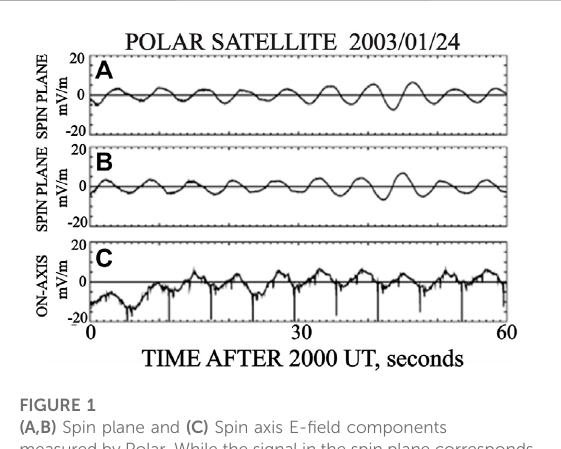
FIGURE 1 (A,B) Spin plane and (C) Spin axis E- fi eld components measured by Polar. While the signal in the spin plane corresponds to a geophysical signal, the signal along the spin axis presents a large error, leading to a large uncertainty in the 3D E- fi eld